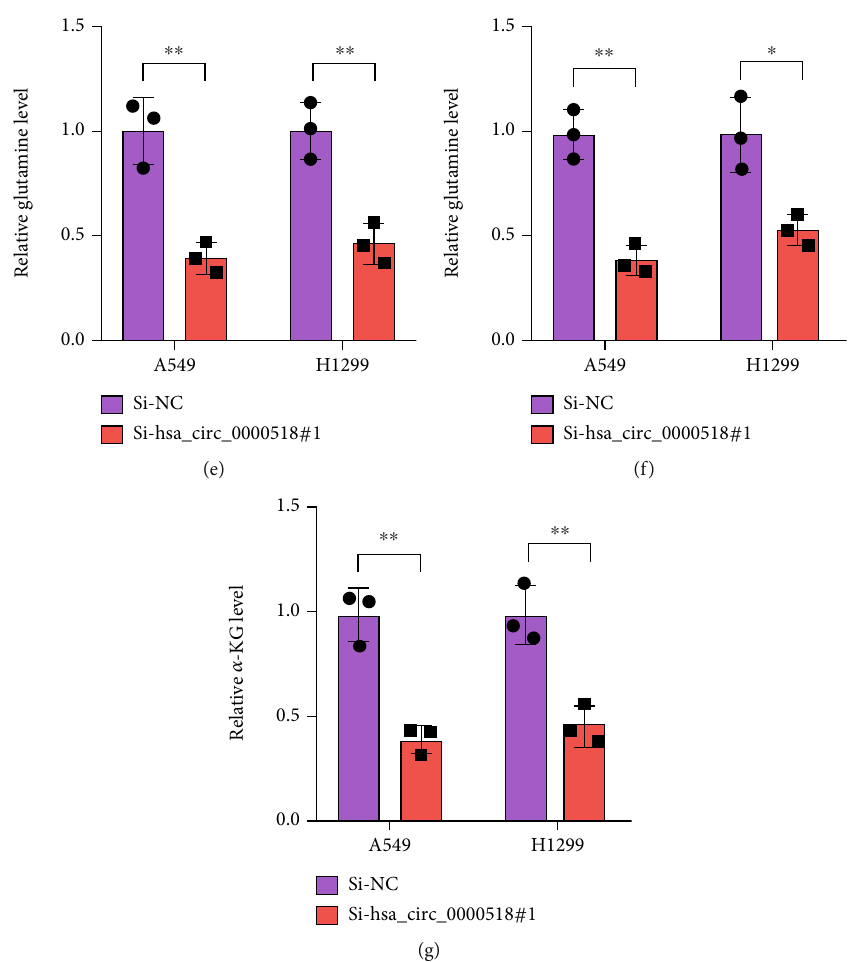
Figure 2: circ_0000518 knockdown restrains NSCLC cell proliferation, invasion, and glutamine metabolism. (a) Relative circ_0000518 levels in cells after the si-circ_0000518 knockdown were evaluated by qRT-PCR. (b) The e ff ects of si-circ_0000518 on NSCLC cell viability were detected by the CCK-8 assay. (c) circ_0000518 knockdown inhibited NSCLC cell invasion by Transwell assay. (d) E ff ects of knockdown of circ_0000518 on vimentin, E-cadherin, and Ki-67 expression. (e – g) Glutamine, glutamate, and α -KG levels were examined. ∗ p < 0 : 05 , ∗∗ p < 0 : 01 , ∗∗∗ p < 0 : 001